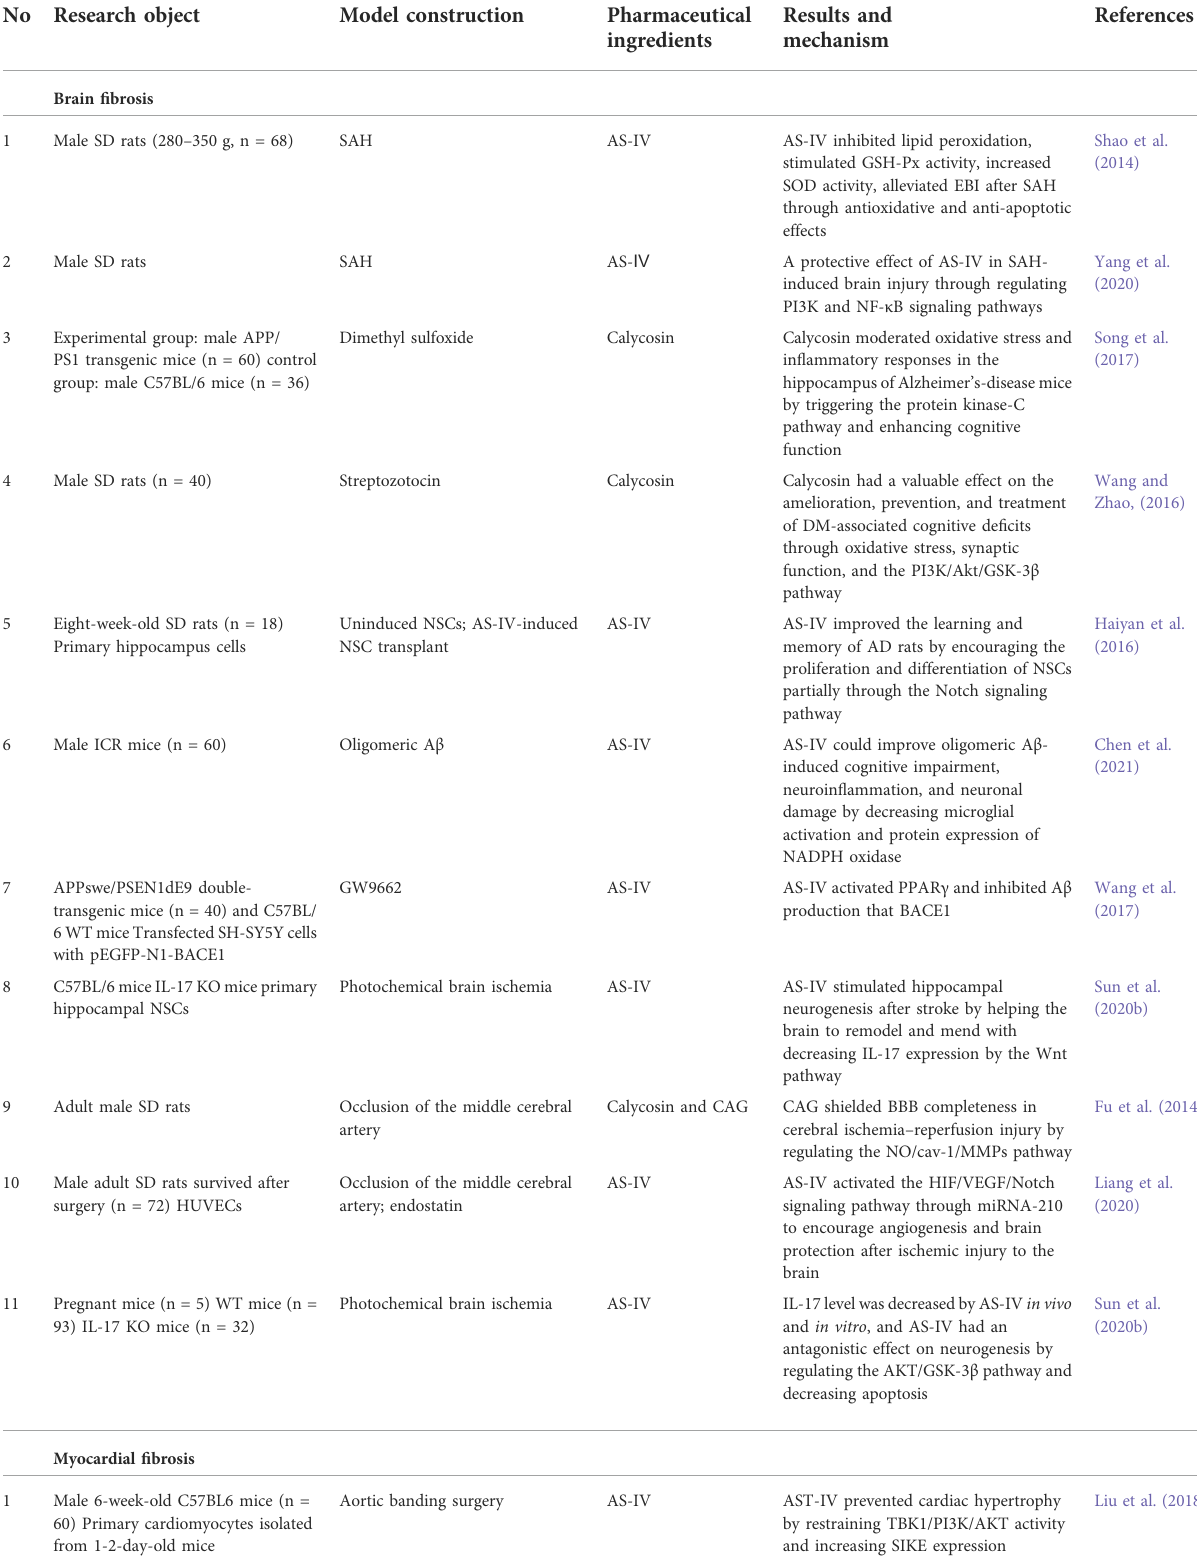
TABLE 1 Studies on single ingredients of Astragalus mongholicus